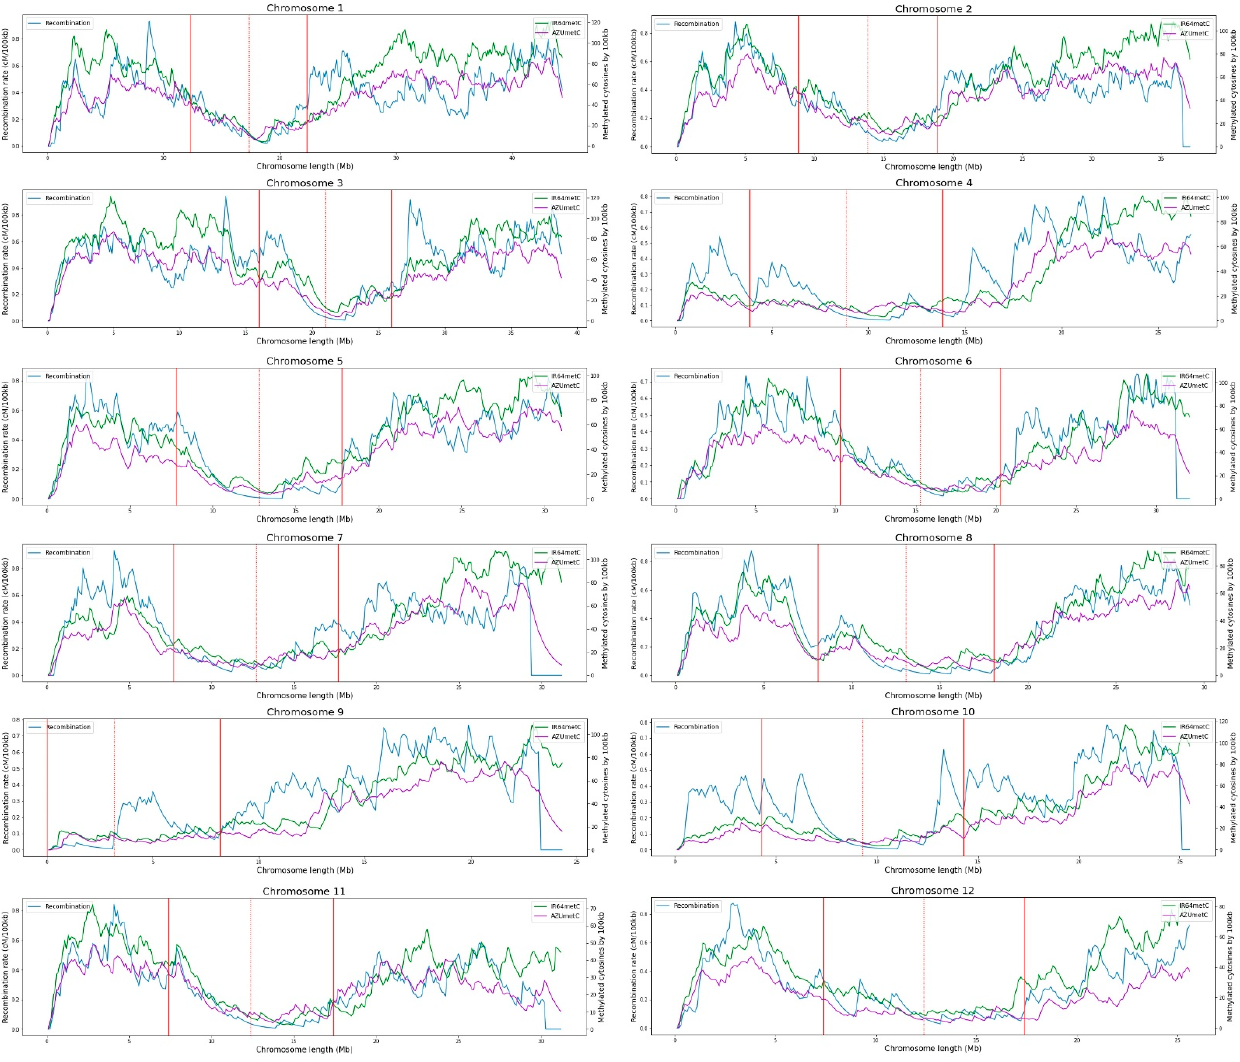
Figure 3. Distribution of methylated cytosines in CHH context in the twelve rice chromosomes for the IR64 and Azucena varieties, in comparison with the chromosomal recombination between these two varieties. The centromere is represented by a red dotted line and the influence of the centromere region in recombination by solid red lines.